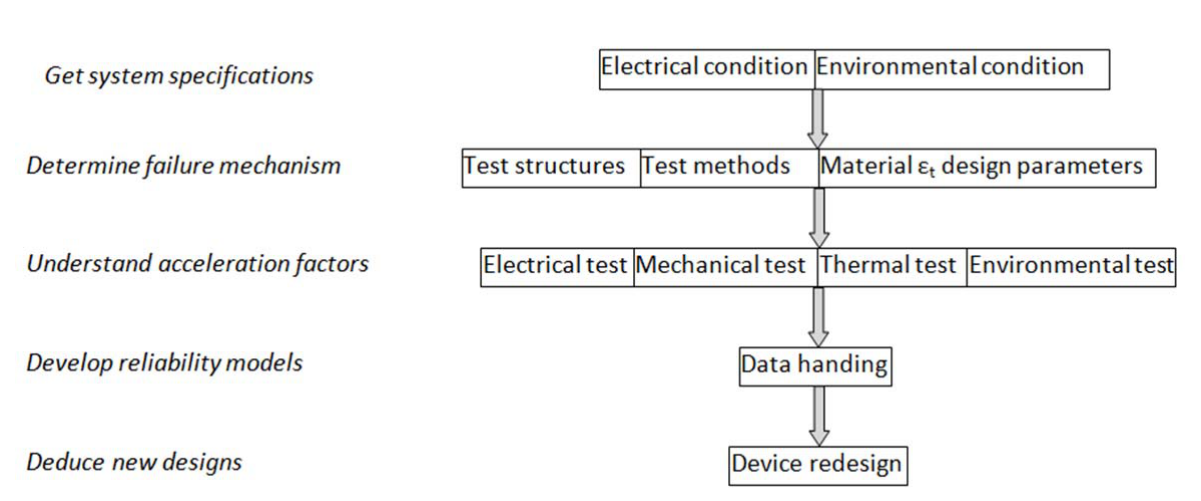
Figure 15. Scheme of microsystem reliability issues analysis methodology (after